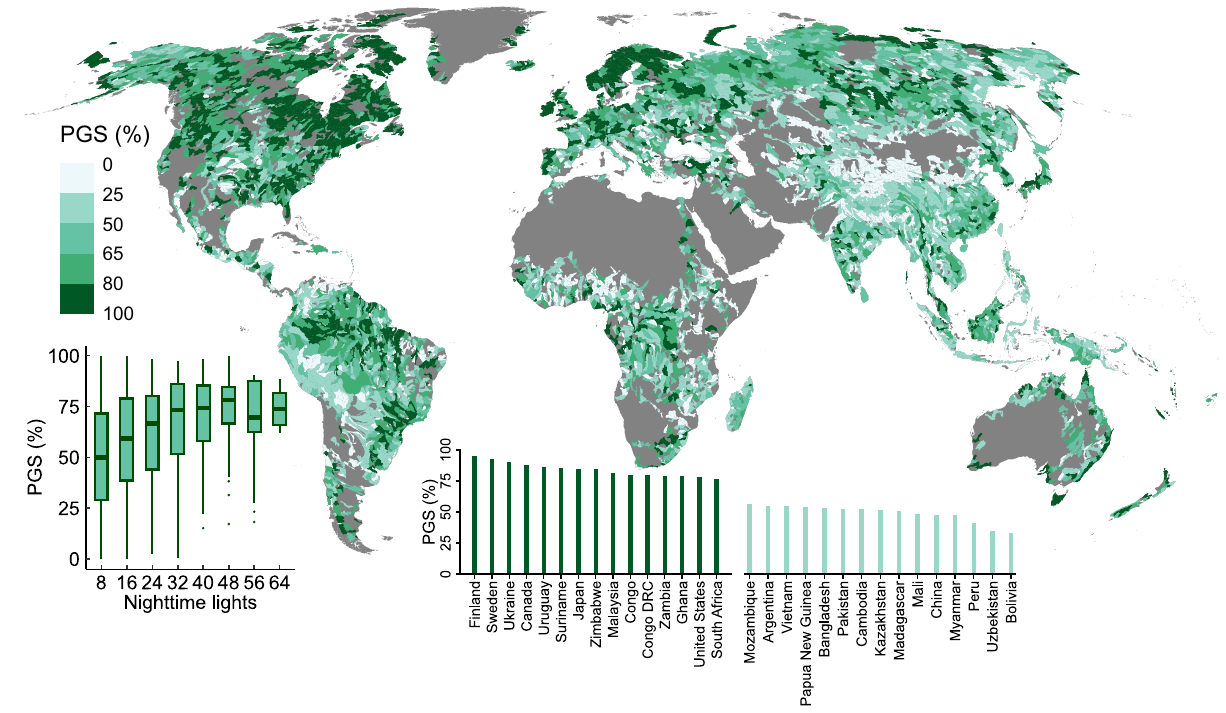
Fig.8|Thedistributionofstableriverextentanditscorrelationwithnighttime light intensity. The map shows the percentage of river area with generally stable extent (PGS,%) in each level-6 basin. The top15 countries/regions with the highest PGS and the lowest PGS among the top 50 counties with the largest river area are